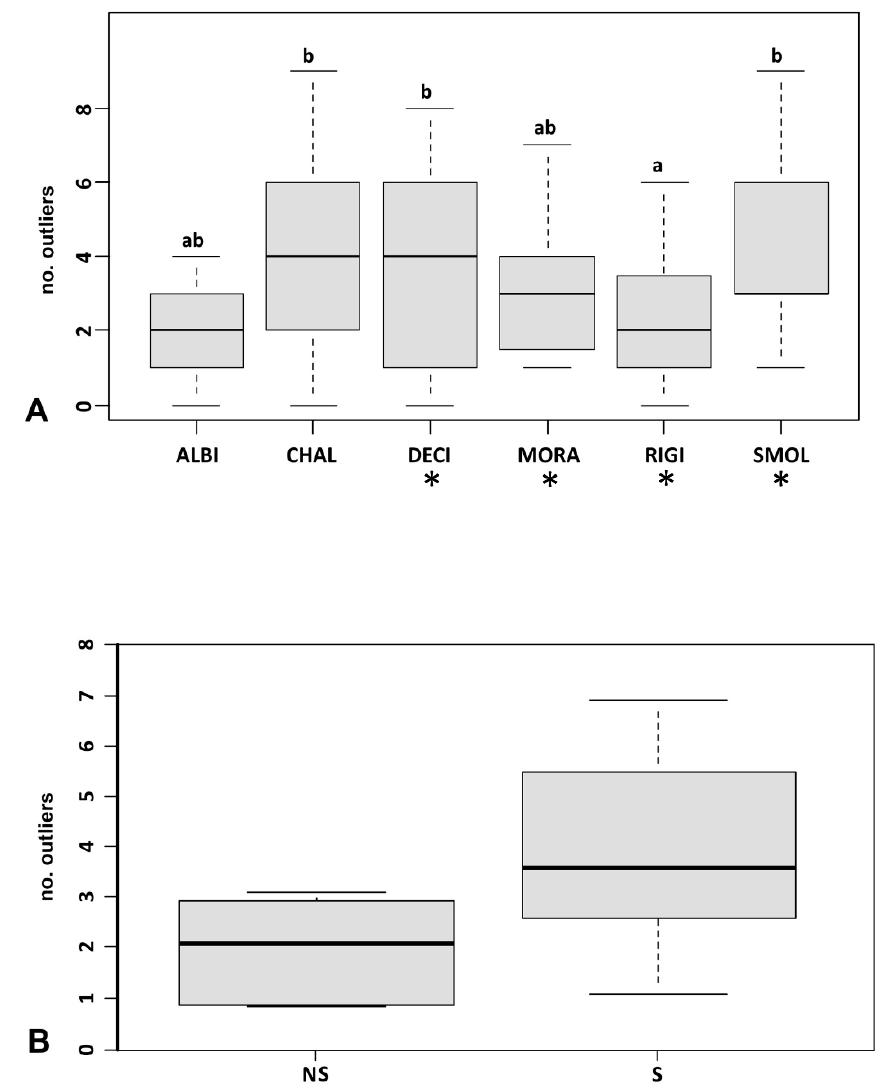
Figure 5. ( A ) Box-whisker plots of outlier variation across the six Albanian taxa (ALBI: O. albiflora ; CHAL: O. chalcidica ; DECI: O. decipiens ; MORA: O. moravensis ; RIGI: O. rigida ; SMOL: O. smolikana subsp. glabra ); asterisks indicate the serpentine obligate taxa, and letters indicate statistically different groups at p < 0.05; ( B ) variation in serpentine (S) vs. non-serpentine (NS) accessions.